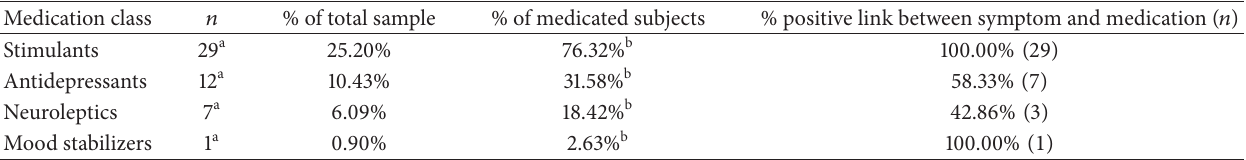
Table 1: Descriptive statistics for psychotropic medication use and link between target symptom and